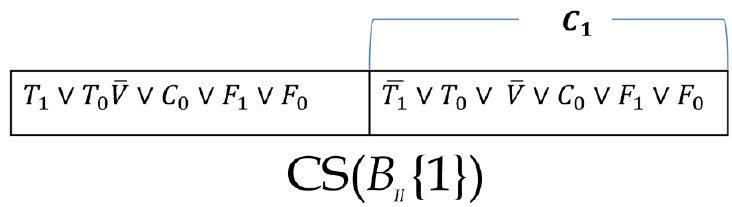
Fig. 15. The VEKM in Fig. 14 after being folded w.r.t. 𝑭 . Note that (𝑪 ∨ 𝑭 ) is common to both cells of the map and hence are sure to make their way to ultimate membership in CS( 𝑩